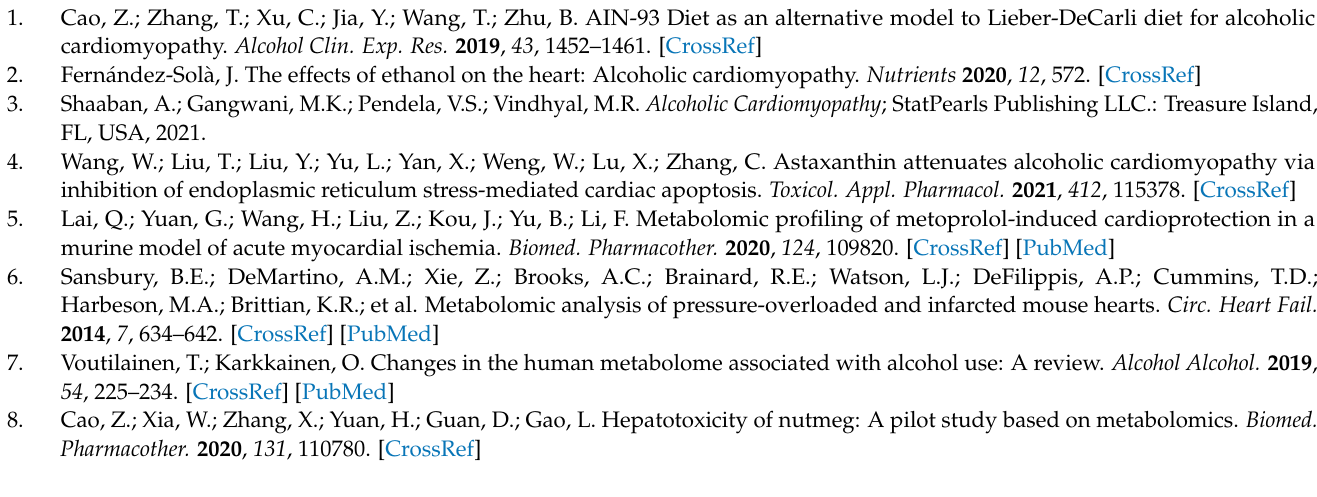
Supplementary Materials: The following are available online, Figure S1. The heart/body weight ratio (# p < 0.01). Figure S2. Representative Sirius red staining of myocardium (200 × ). (A) Control group (400 × ); (B) ACM group. Figure S3. Pearson’s correlations between quality control (QC) samples. (A) Positive mode; (B) Negative mode. Figure S4. Principal components analysis (PCA) among the control and ACM groups and QC samples. (A) Positive mode; (B) Negative mode. Figure S5. Permutation tests (200 times) performed in the PLS-DA model. (A) Positive mode; (B) Negative mode. PLS-DA, partial least squares discriminant analysis. Table S1. The main KEGG pathways based on the differentially expressed metabolites in positive mode. Table S2. The main KEGG pathways based on the differentially expressed metabolites in negative